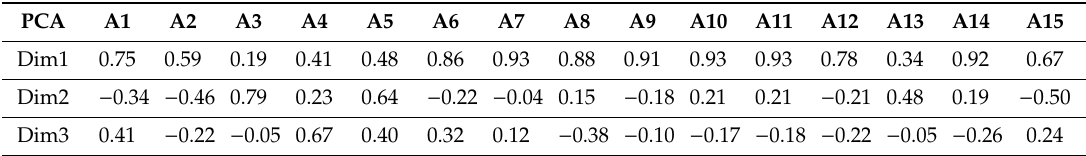
Table 4. Component matrix for the three principal